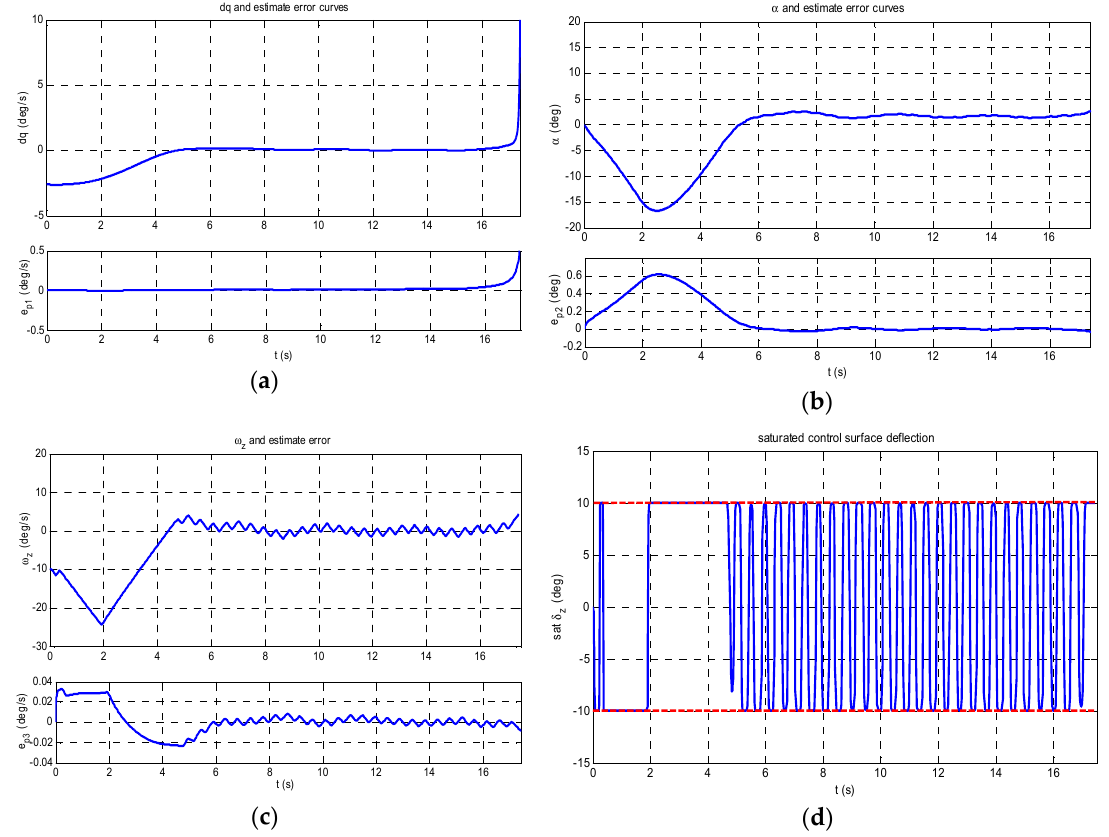
. q and NESOI, ( b ) comparison δ ω and NESOIII, and ( d ) saturated z curve. z